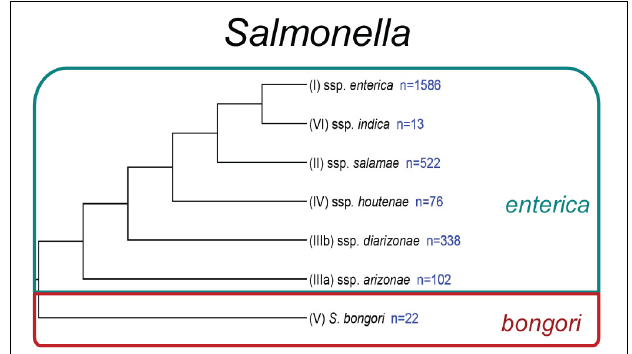
FIGURE 1 | Phylogeny of Salmonella . Phylogenetic analysis reconstructed from Desai et al. (2013). Subspecies identifiers preceding the subspecies (ssp.) name are shown in parentheses. The number of currently recognized serovars (Issenhuth-Jeanjean et al., 2014) within each species or subspecies is listed in